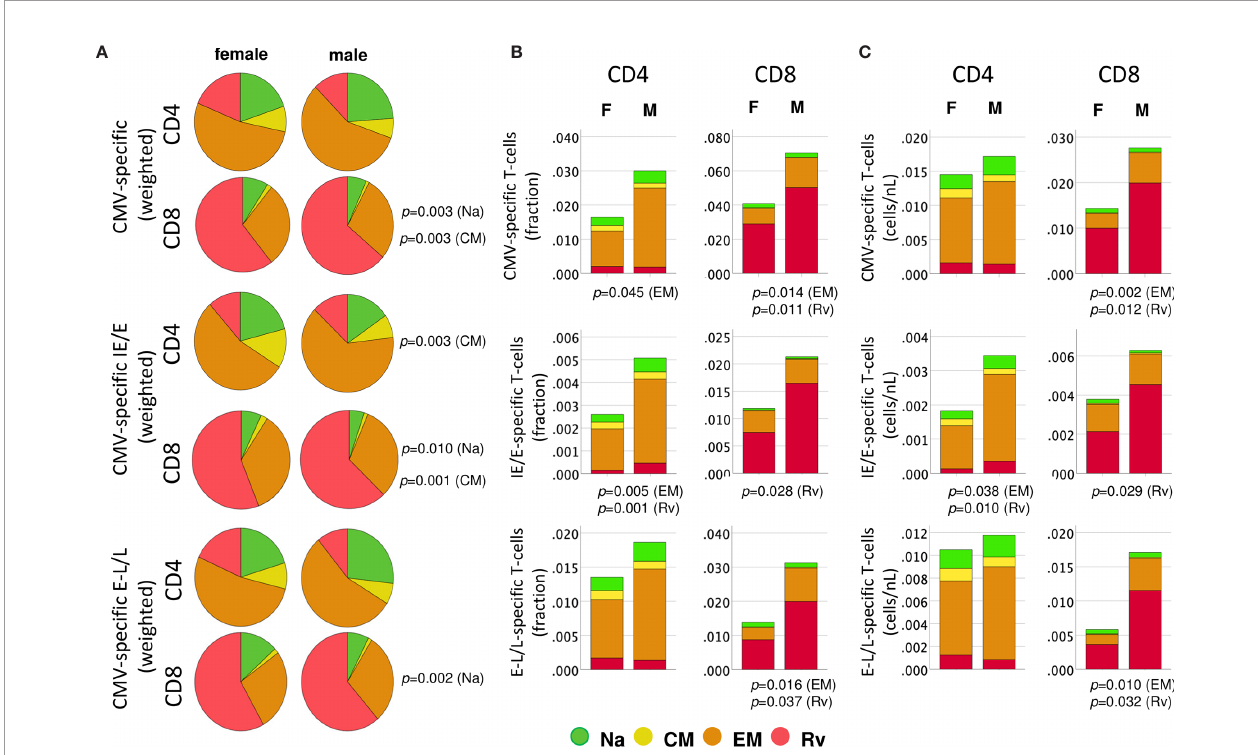
FIGURE 4 | Distribution of protein-speci fi c T-cells across canonical blood T-cell subsets by protein kinetic class. CMV-speci fi c T-cells (any activation marker) were analyzed in regards to memory subset composition including naïve-like/stem-cell memory (Na, CCR7+CD45RA+, green), central memory, (CM, CCR7+CD45RA-, yellow), effector memory (EM, CCR7-CD45RA-, orange) and revertant memory (Rv, CCR7-CD45RA+, red). (A) Pie charts show weighted average percentages of memory T-cell subsets (composition). Top, middle, and bottom panels show all CMV-protein reactive T-cells, IE/E-protein-and E-L/L-protein-speci fi c T-cells, respectively. Weighted percentages were obtained by adding up responder frequency for all selected proteins, and then the sums for each subset were normalized to 100%. (B) Stacked bar charts show non-normalized CD4 or CD8 T-cell subset percentages added up across all CMV proteins, IE/E and E-L/L proteins, visualizing overall subset size differences between men and women. (C) Stacked bar charts show non-normalized CD4 or CD8 T-cell counts/nL of blood added up across all CMV proteins, IE/E and E-L/L proteins, providing an alternative visualization of subset size differences between men and women. p- values indicate signi fi cant ( p ≤ 0.05) differences between females and